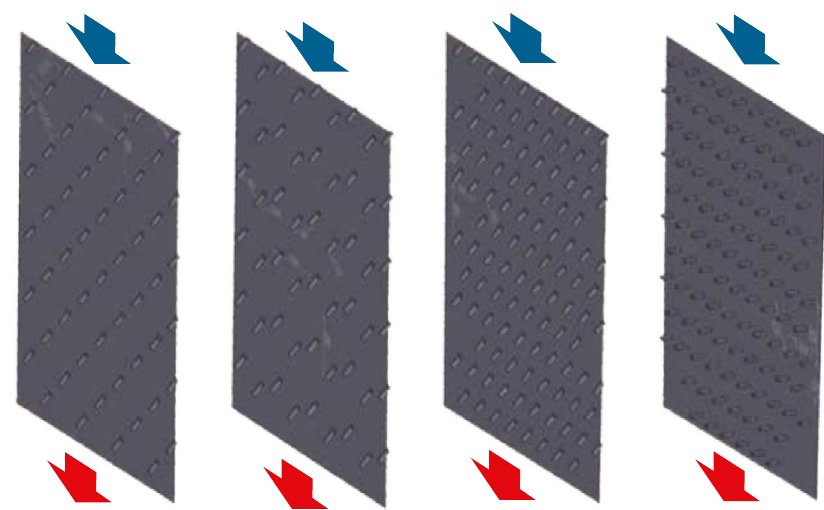
Figure 3: Placement and arrangement of fi n con fi